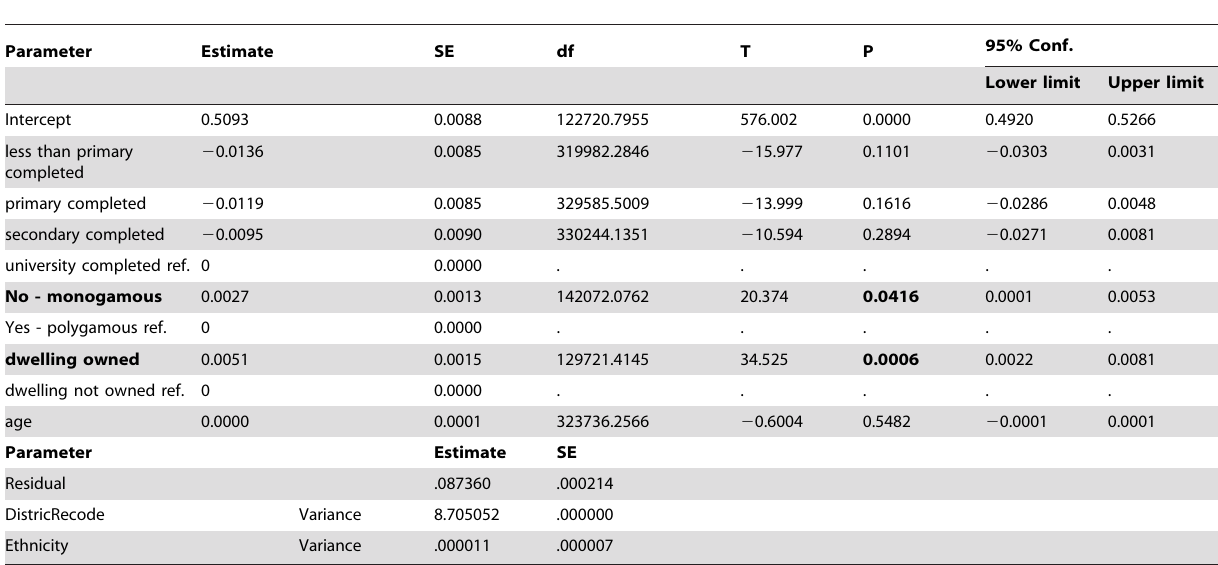
Table 1. LMM of age, type of marriage, education and ownership of dwelling (ethnicity and Uganda district as random factors) regressing on SRB.